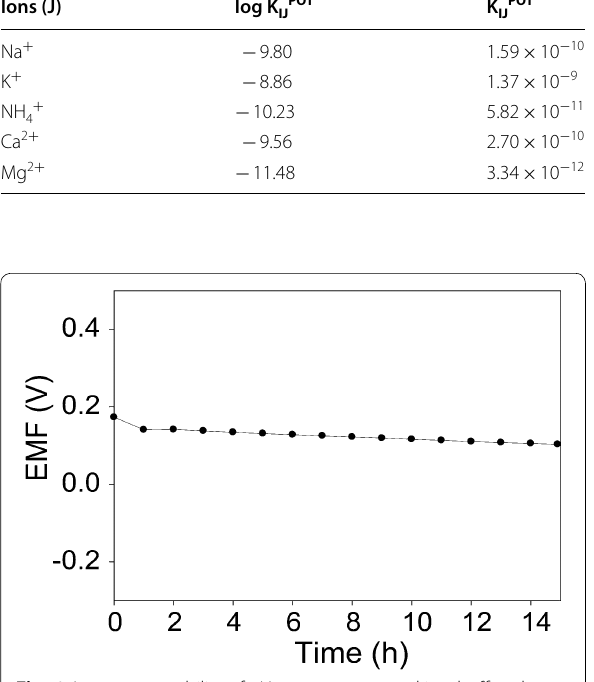
Fig. 6 Long-term stability of pH sensors measured in a buffered solution at pH